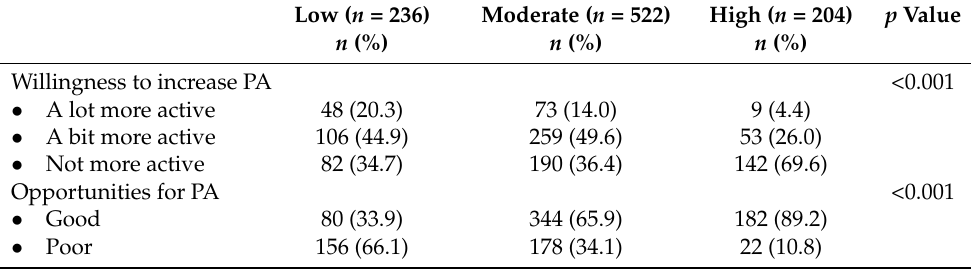
Table 2. Willingness to increase and opportunities for physical activity according to physical activ- ity level.